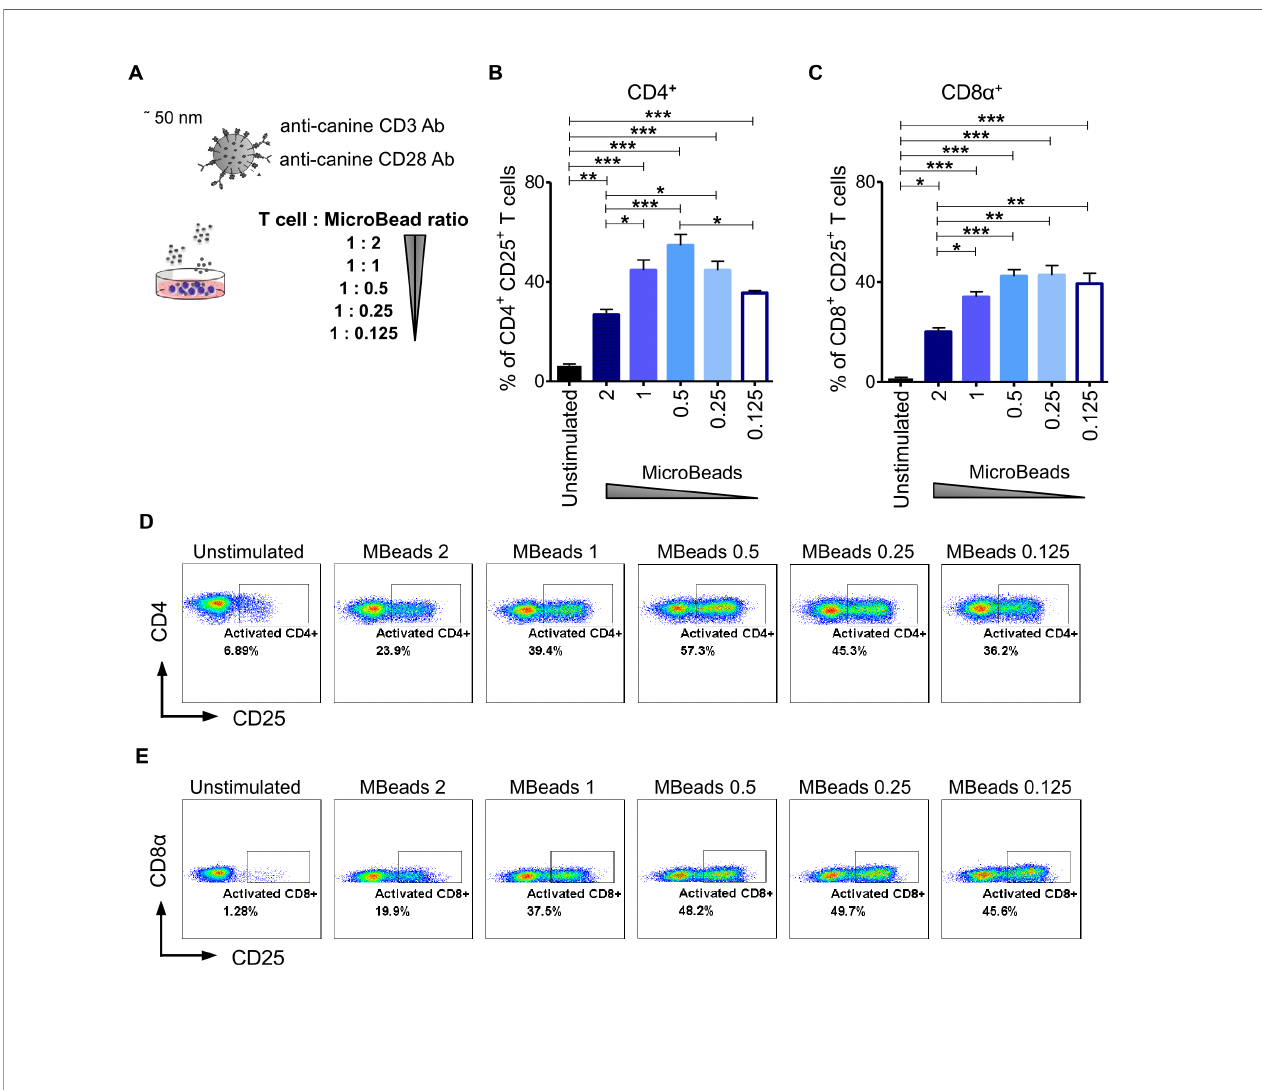
FIGURE 3 | Activation signal strength in fl uence on the expression of CD25 in canine T lymphocyte. (A) The graphical scheme of experiment with application of different T cell to MicroBead ratios. Quanti fi cation of activated CD4 + CD25 + (B) and CD8 a + CD25 + (C) canine T cells depending on activation signal strength provided by different MicroBeads concentrations. Data are shown as the mean of fi ve dogs (n=5), and error bars indicate SEM. Statistical analysis was performed by unpaired Student ’ s t -test (* p < 0.05, ** p < 0.01, *** p < 0.001). (D, E) Representative cytograms of CD25 expression in CD4 + and CD8 a + T lymphocytes after stimulation with different T cell to MicroBead ratios (FASC Aria II, Becton